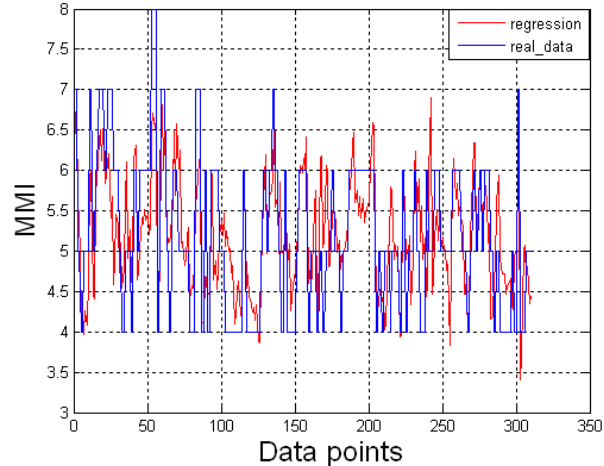
Table 4. The statistical parameters obtained for the linear regression using the ANOVA test.